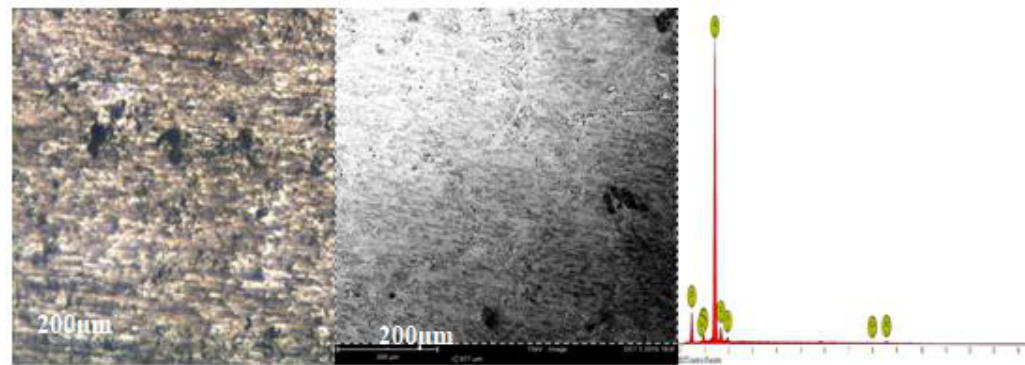
Fig. 5. Optical micrograph, SEM and EDS of Al 5 wt.% Zn at 1200.